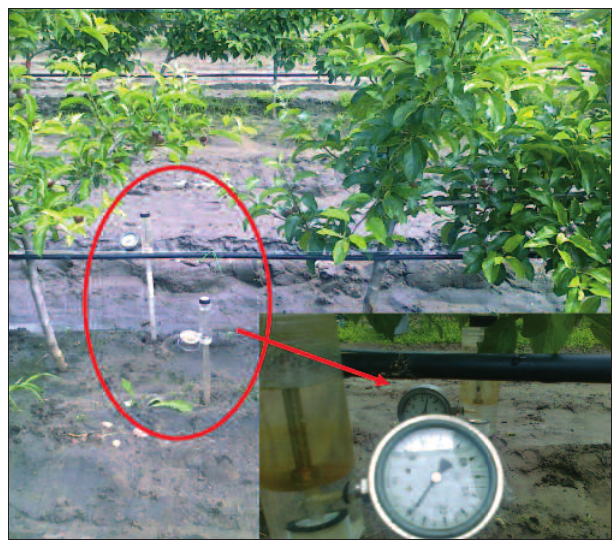
Figure 1: Tensiometers at 40 and 70 cm